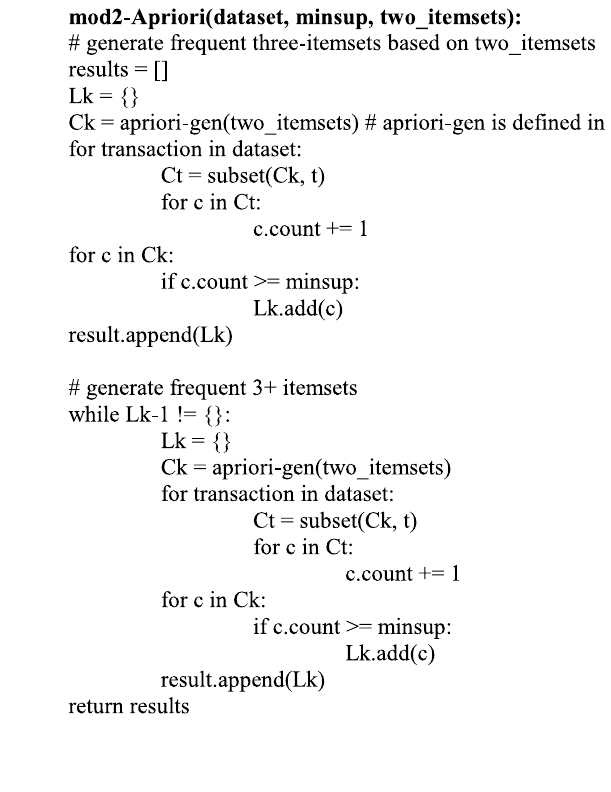
Finding frequent 2 itemsets using the Apriori algorithm or dirct_gen algorithm The first step of the SARL heuristic is to find the frequent 2 itemsets